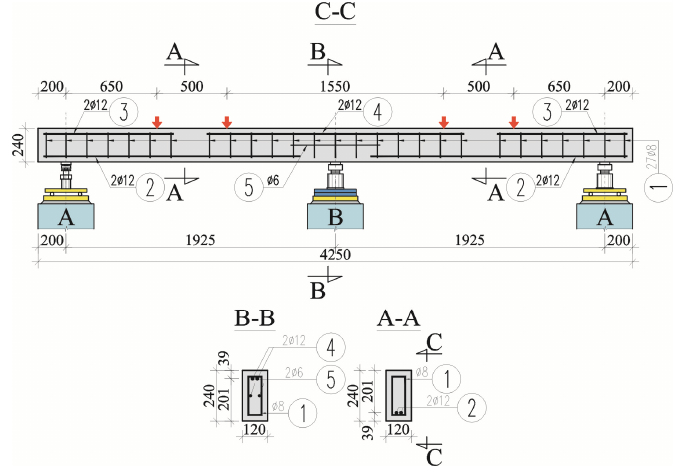
Figure 10. Geometry and reinforcement of beams.